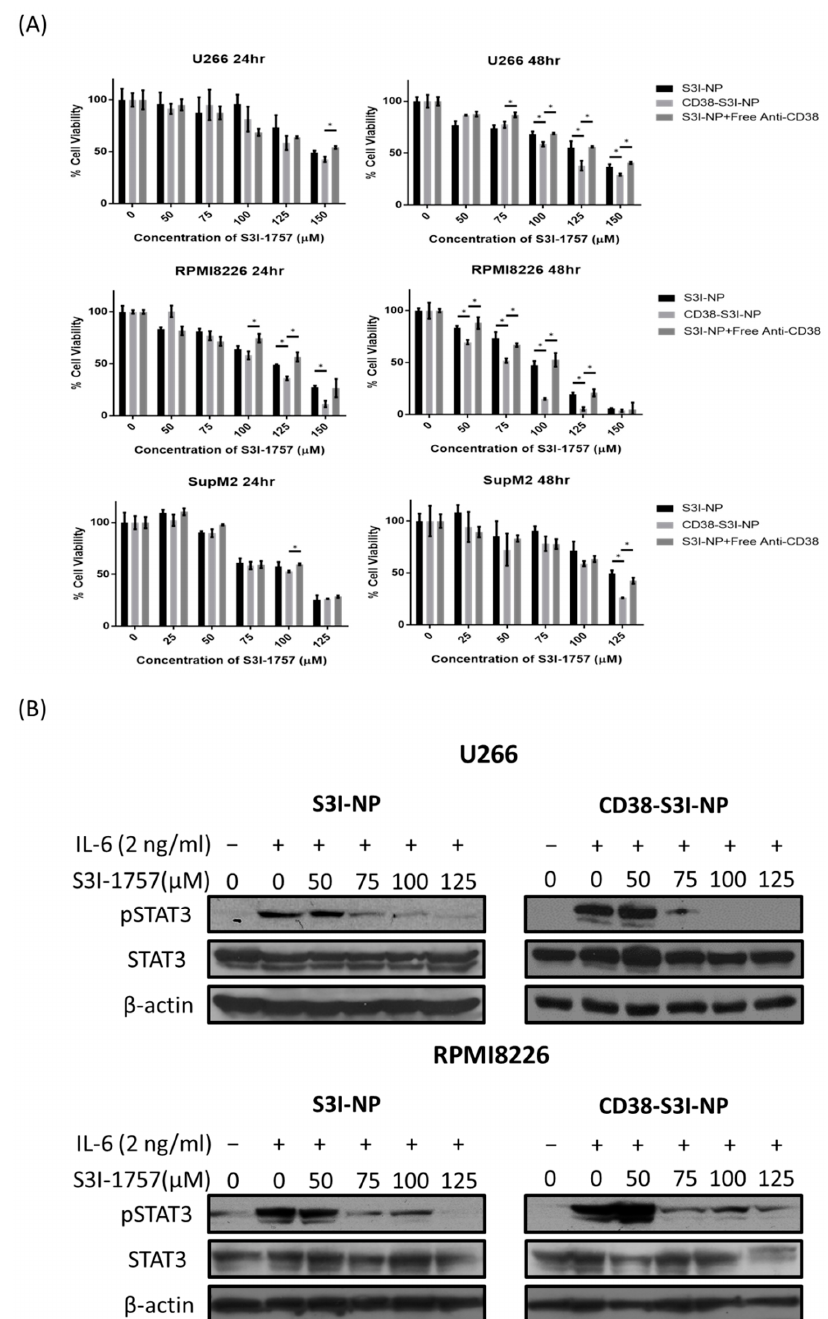
Figure 3. CD38-S3I-NP induces cytotoxicity and inhibits STAT3 activity in MM cells. ( A ) U266 and RPMI8226 cells were then treated with S3I-NP, CD38-S3I-NP, or S3I-NP with free CD38 antibody at a concentration which is equivalent to CD38-S3I-NP (1.4 mg/mL) with the presence of IL6 (2 ng/mL) for 24 and 48 h. Cell viability was measured using a 3-(4,5-dimethylthiazol-2-yl)- 5-(3-carboxymethoxyphenyl)-2-(4-sulfophenyl)-2H-tetrazolium (MTS) cell viability assay in triplicate; * p < 0.05, via Student’s t -test. ( B ) Western blot analysis of STAT3 and pSTAT3 levels in U266 and RPMI8226 cells treated with S3I-NP or CD38-S3I-NP with the presence of IL6 (2 ng/mL) for 24 h. β -actin was blotted as a loading